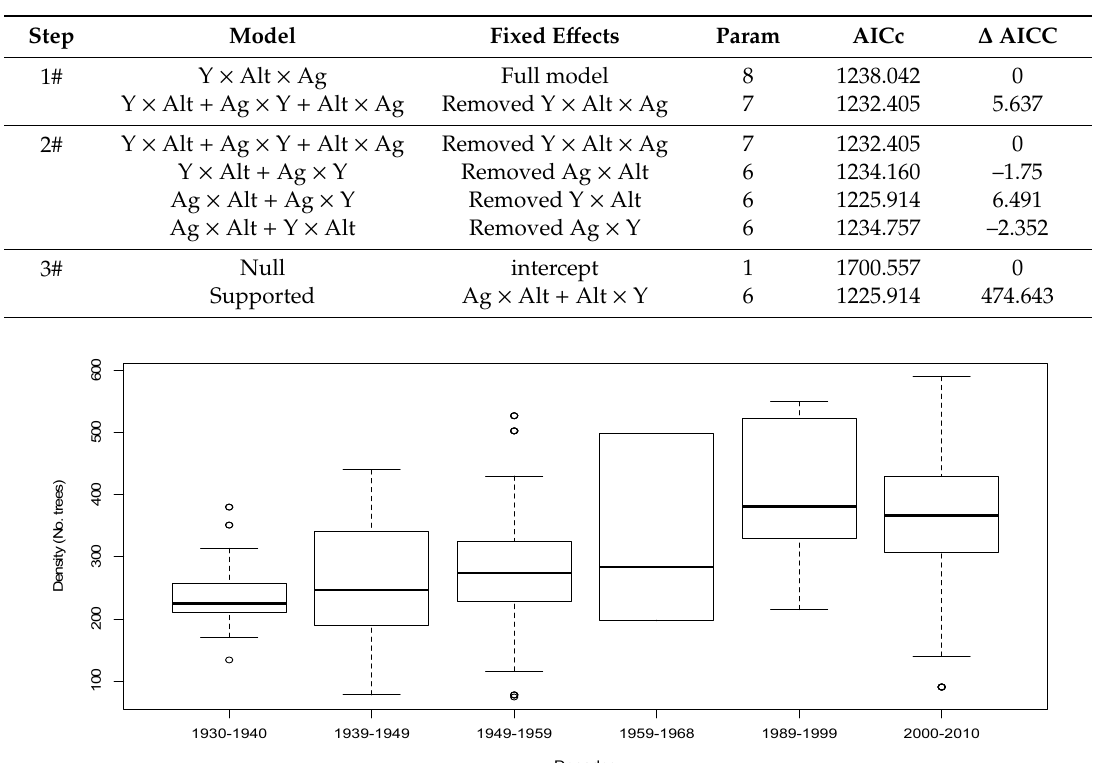
Table 3. Selection of the predictor variables using the corrected Akaike Information Criterion for small sample sizes (AICc).